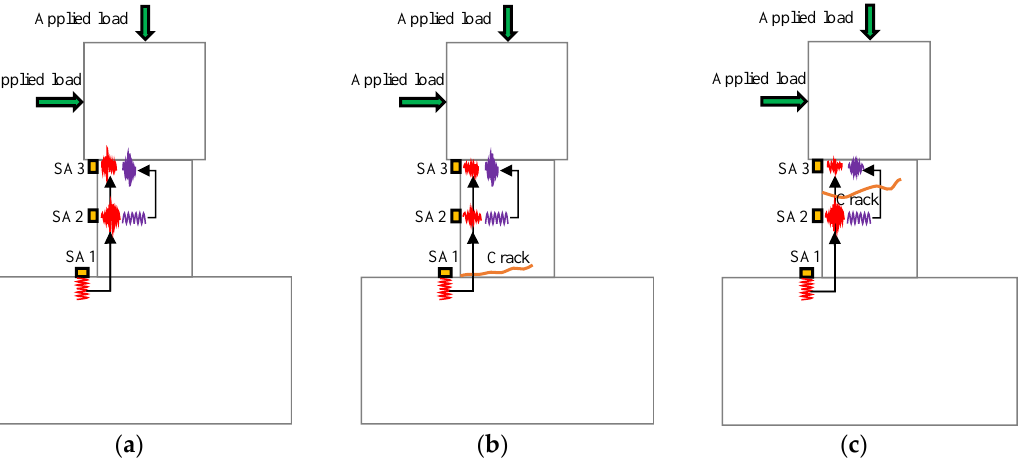
Figure 25. The damage detection principle of a column. ( a ) Healthy status, ( b ) Crack in the lower